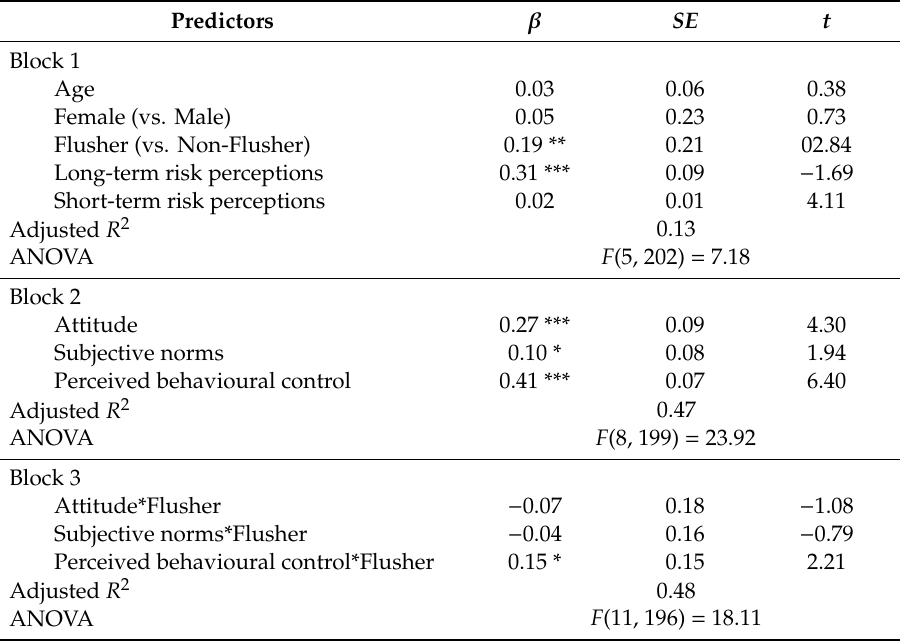
Table 2. Ordinary Least Squares Regression Predicting